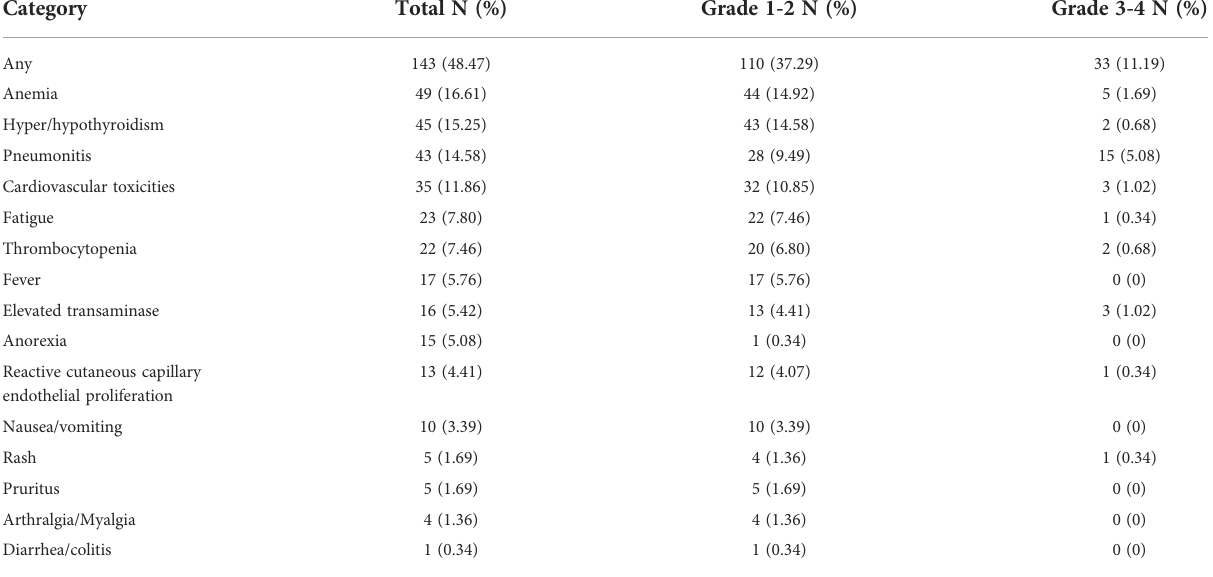
TABLE 1 Immune-related adverse events according to category and